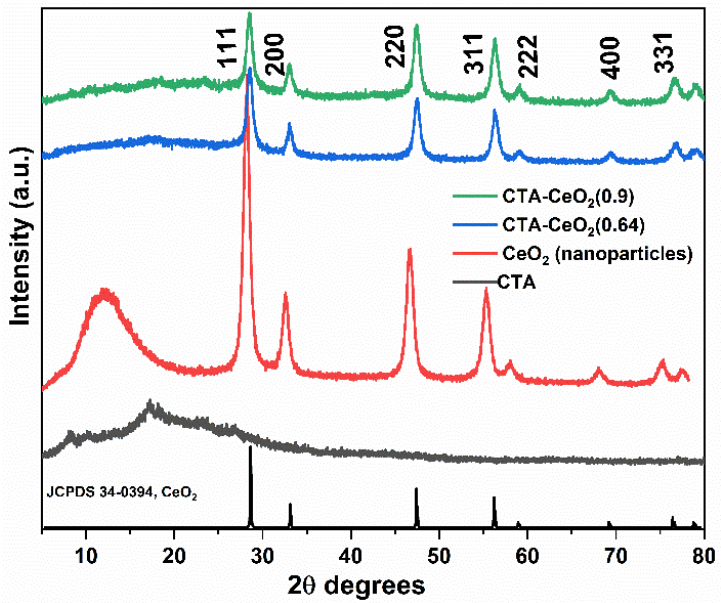
Figure 6. XRD spectral analysis of the synthesized CeO 2 nanoparticles and CTA membrane with different concentrations of CeO 2 nanoparticles.